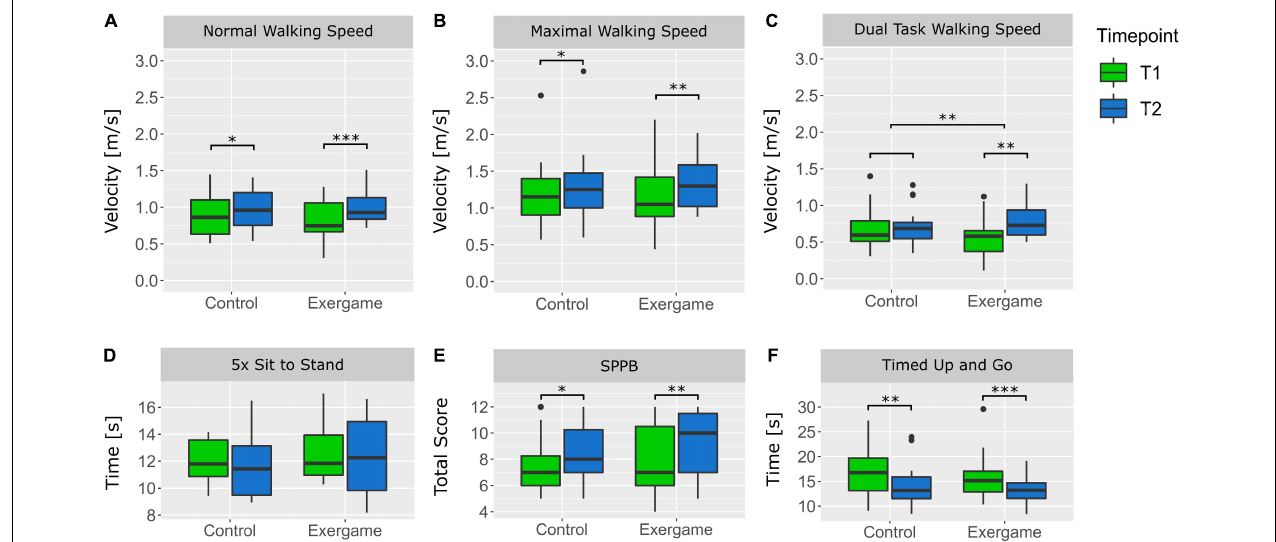
FIGURE 3 | Boxplots of physical outcomes of each group at pre- and post-measurements. (A) Velocity for normal walking 10 m, (B) maximal velocity for walking 10 m, (C) velocity for walking 10 m while dual tasking, (D) Time required to stand up five times, (E) Total Score achieved in the Short Physical Performance Battery (SPPB), (F) Time required for the Timed Up and Go (TUG). ∗ P < 0.05, ∗∗ P < 0.01, ∗∗∗ P <